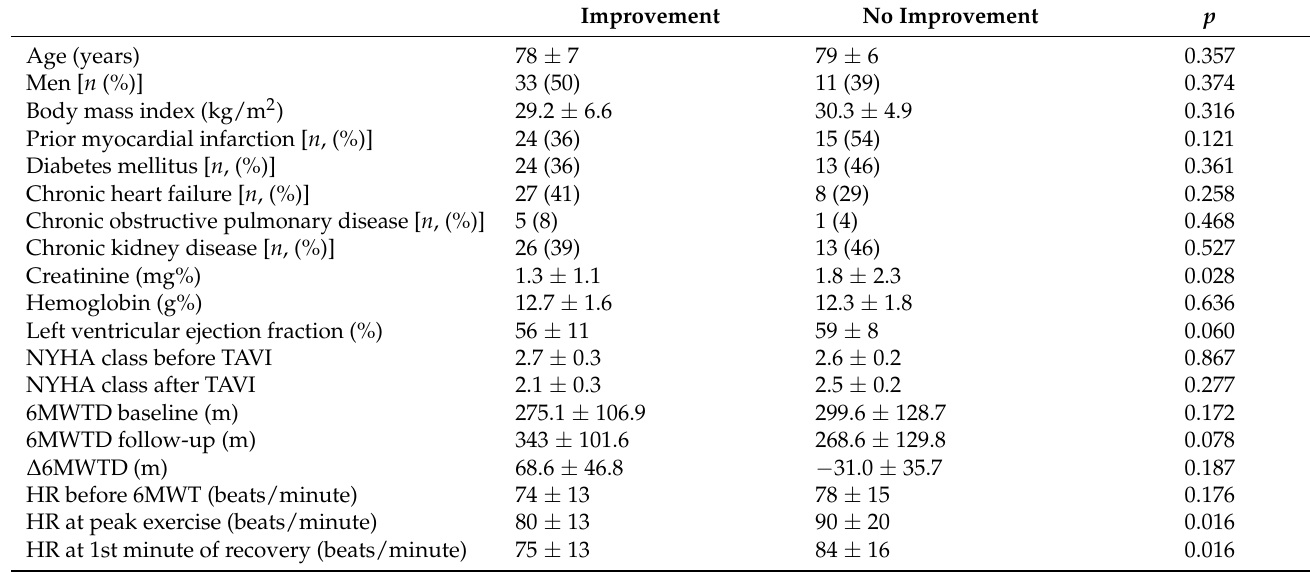
Table 2. Multiple linear regression (backwards method) model for predictors of changes in 6 min Table 3. Comparison of clinical and 6 min walking test parameters in patients with and without walking test distance from baseline to 3 the month follow-up after transcatheter aortic valve replace- walking distance improvement after transcatheter aortic valve replacement ment.